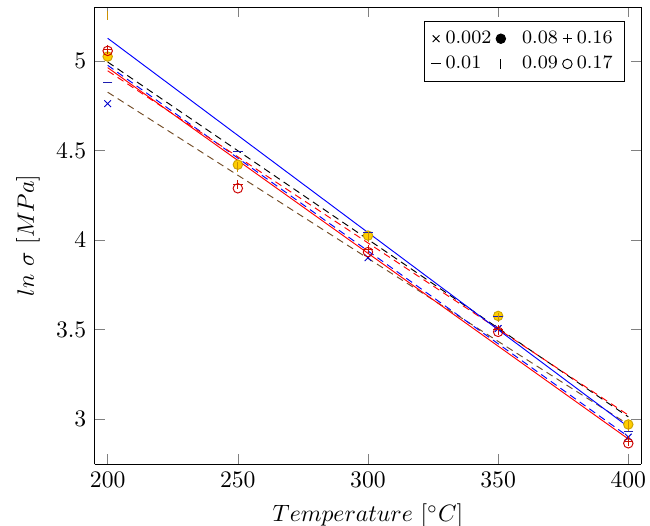
Figure 3. Relationship between the logarithmic stress ln σ and the temperature T for the sample formed in the tool with a temperature of 350 ◦ C. The different lines are representing different strain values. For the sake of brevity and to provide a better overview, only 6 representative lines out of the originally 21 lines are shown.